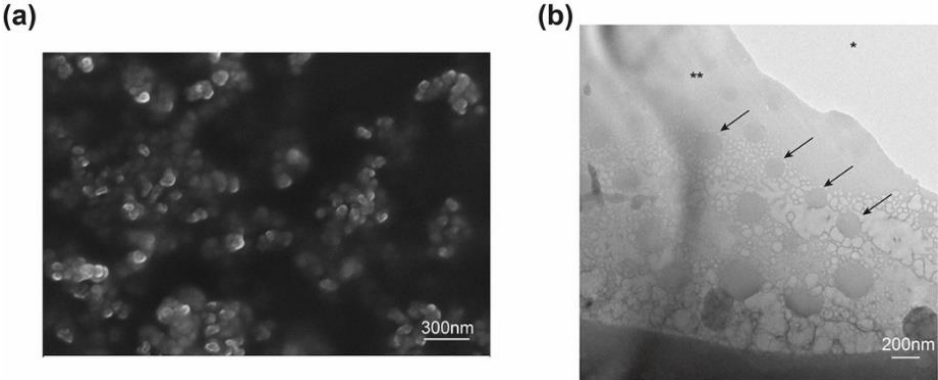
Figure 1. ( a ) Scanning electron microscope (SEM) image of curcumin nanoparticles (Cur NP). ( b ) Representative cryogenic transmission electron microscope (Cryo-TEM) image of the Cur NP/hydrogel composite. Arrows indicate Cur NP; * TEM cooper grid, ** Gel composite.